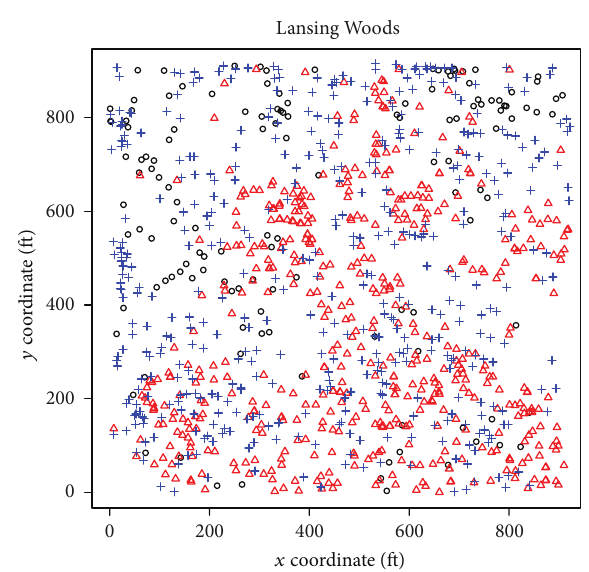
Figure 1: The scatter plot of the locations of black oaks (circles ∘ ), maples (triangles 󳵻 ), and white oaks (pluses +) in the Lansing Woods, Clinton County, MI, USA.